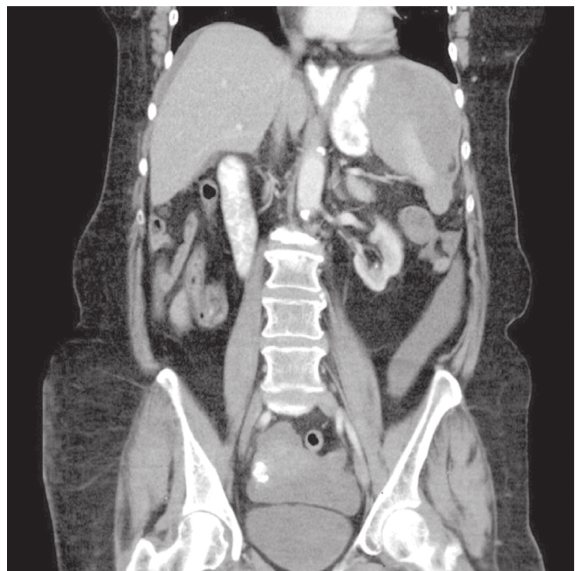
Figure 1: Coronal CTsection of the abdomen and pelvis showing a large splenic hematoma.